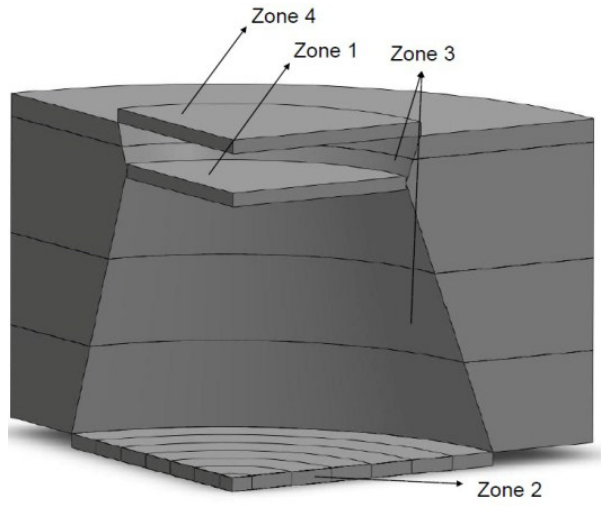
Figure 3. Example surfaces involved in radiation exchange in thermal